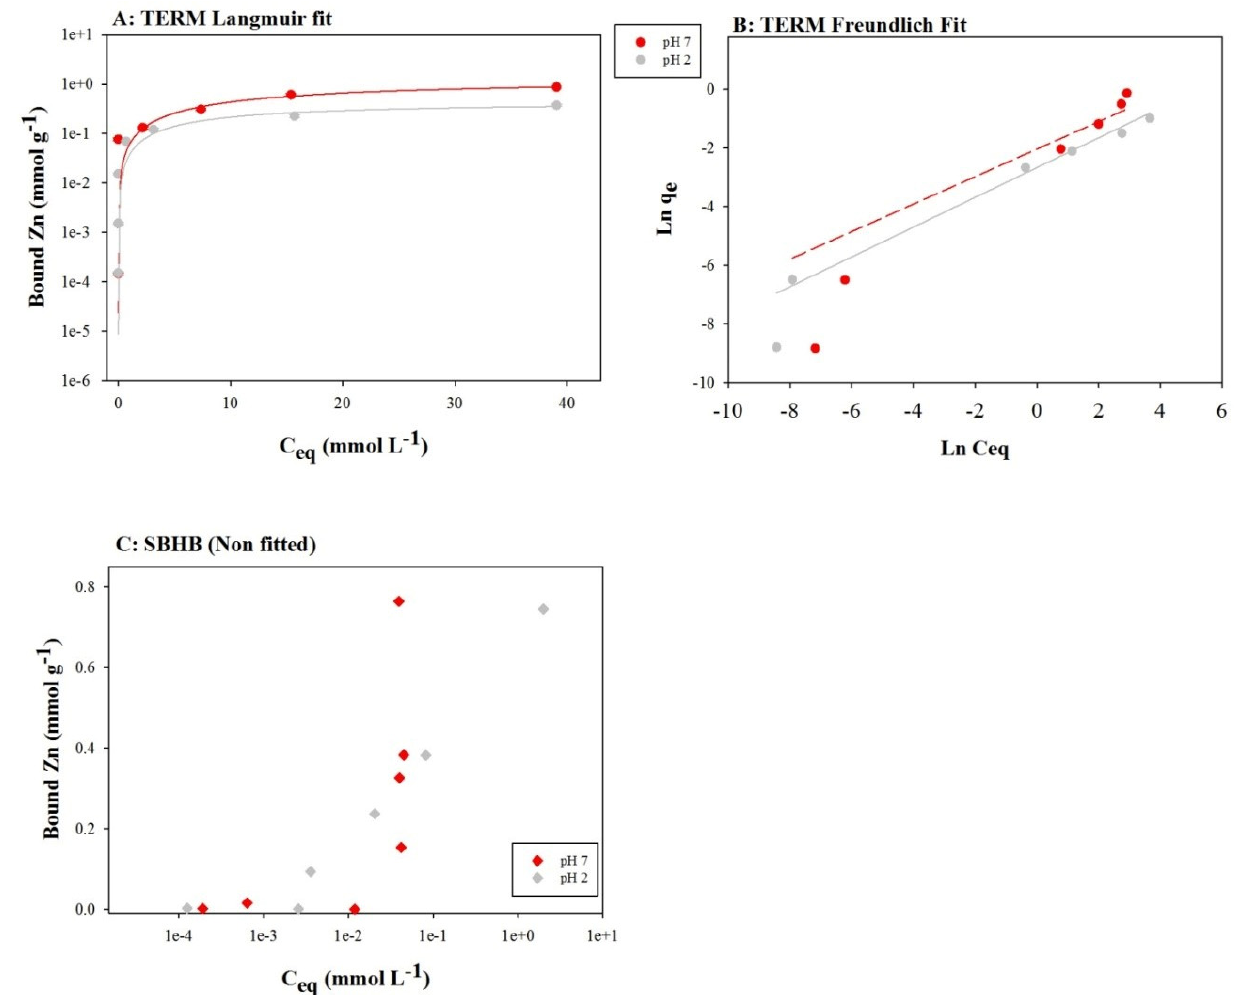
Figure 6. Zn binding on the Thermo-Evolved Red Mud (TERM) and the Slag Based Hydraulic Binder (SBHB). The pH (2 and 7) are for the levels of acidity before aqueous Zn 2+ /adsorbents .